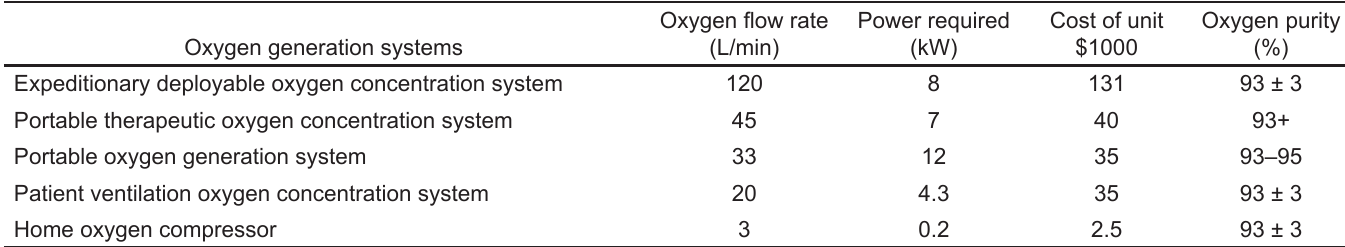
Table 5. Oxygen equipment typically available.